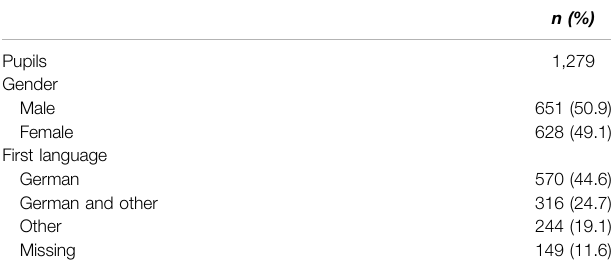
TABLE 1 | Descriptive characteristics of the